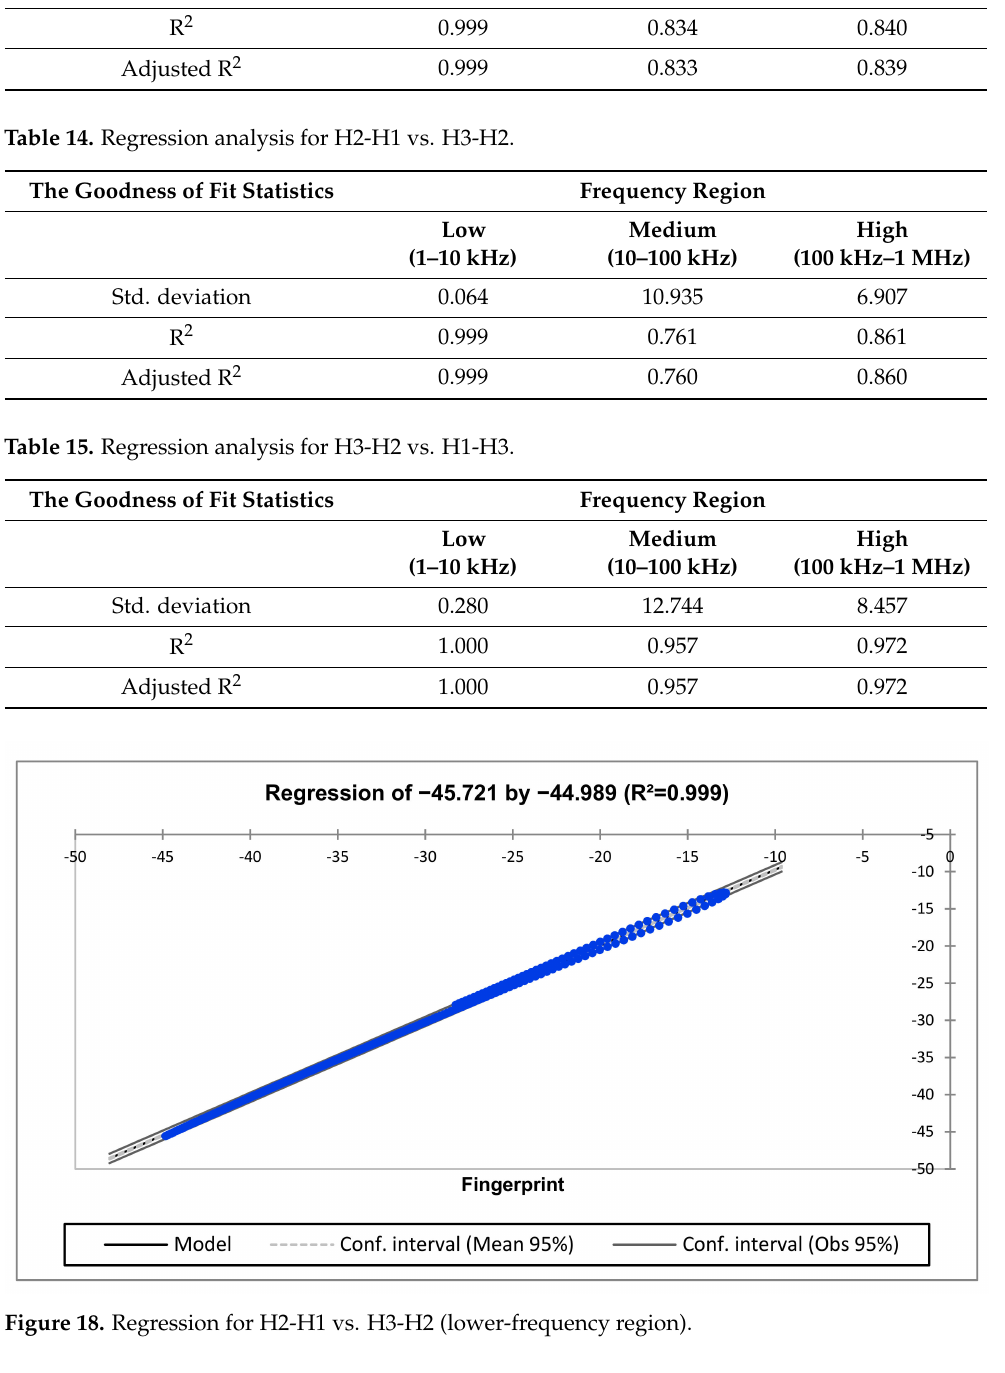
Figure 18. Regression for H2-H1 vs. H3-H2 (lower-frequency